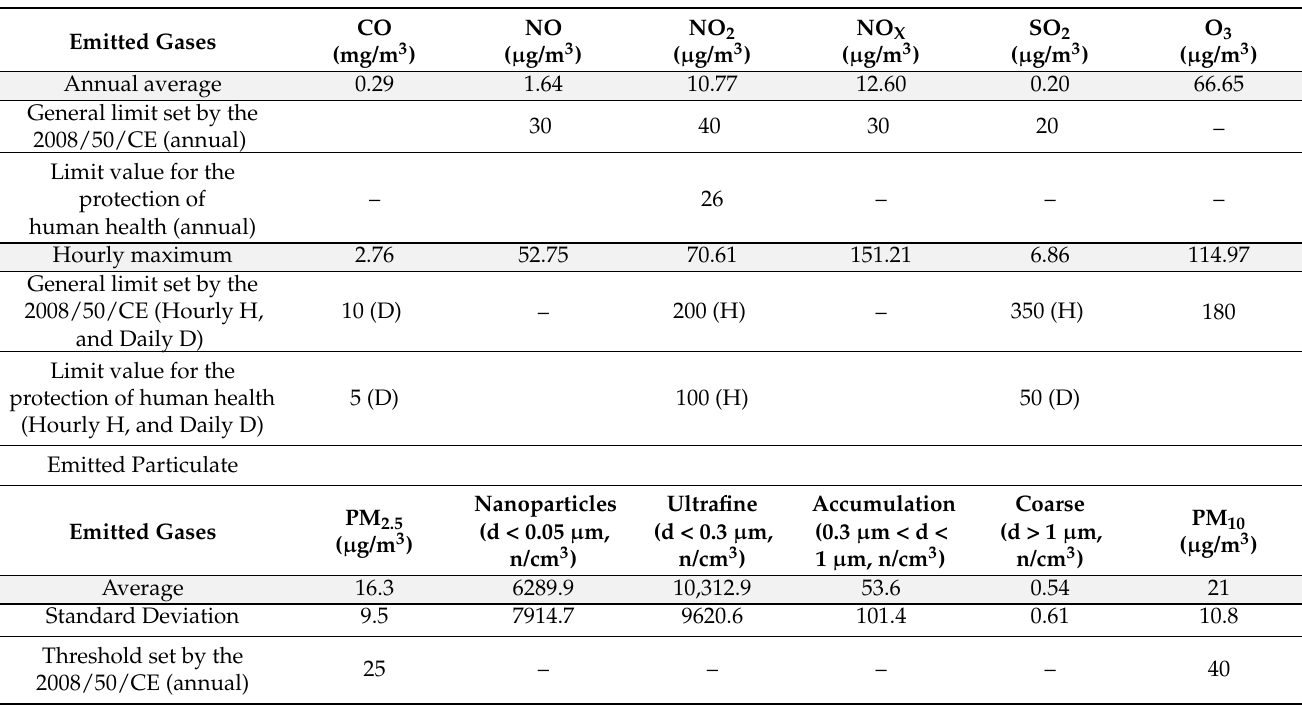
Table 8. Annual average and maximum hourly values in comparison to the limits prescribed by the European Directive 2008/50/CE